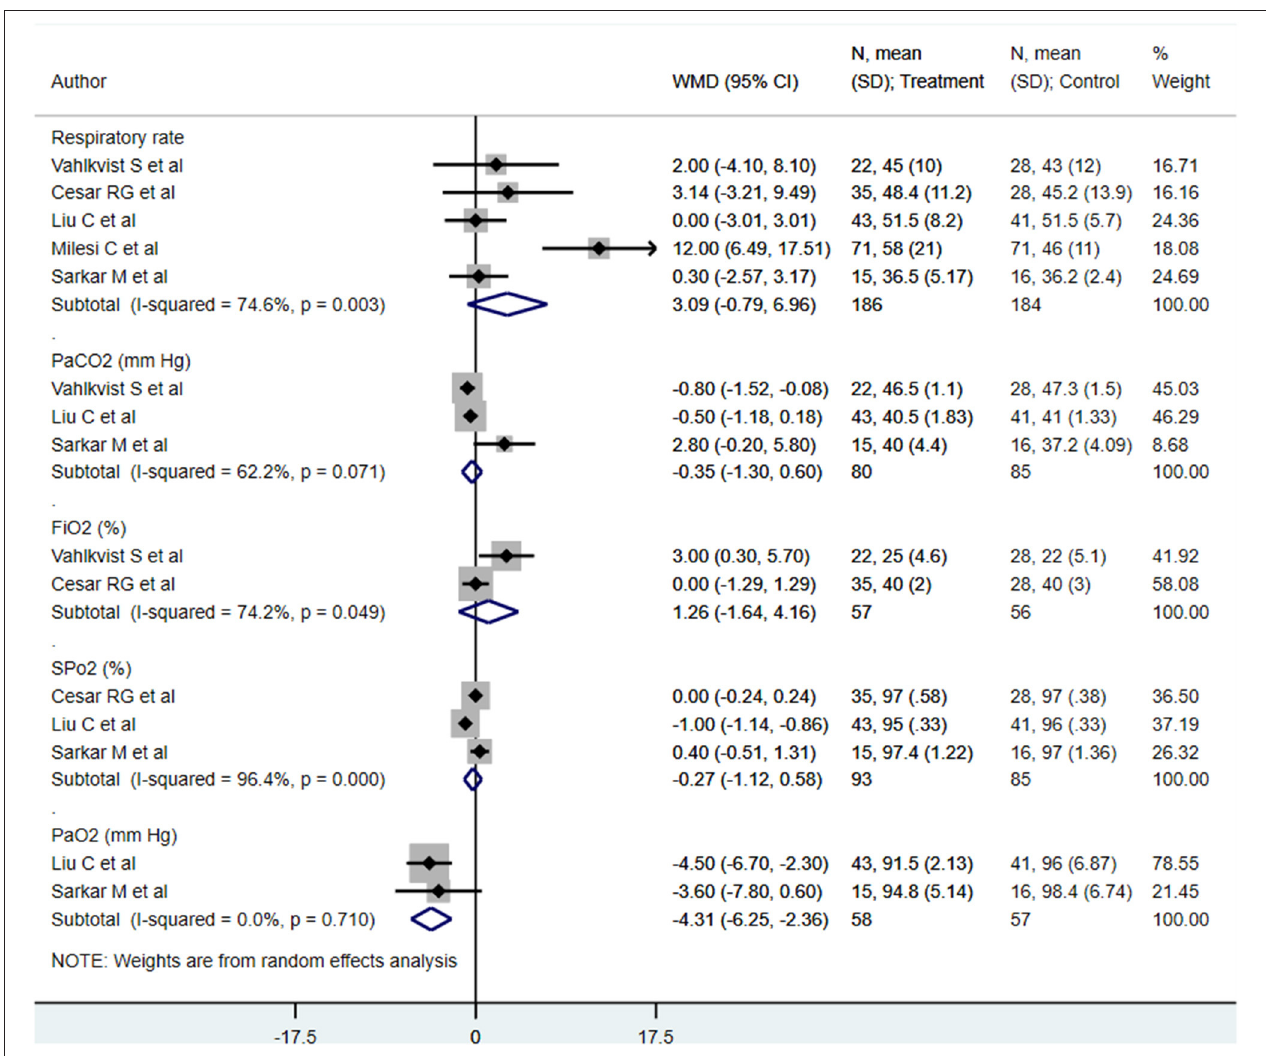
FIGURE 4 | Effect of HFNC vs. CPAP on respiratory rate, PaCO 2 , FiO 2 , SpO 2 , and PaO 2 .